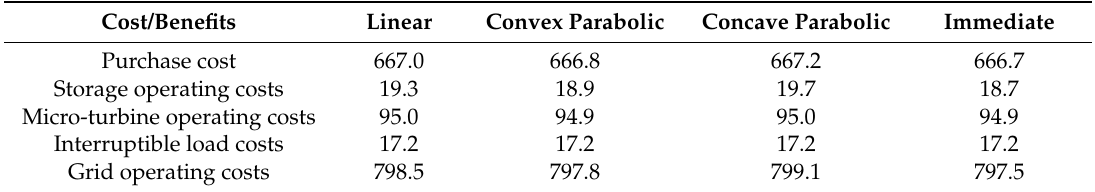
Table 6. Cost and benefit of different time response